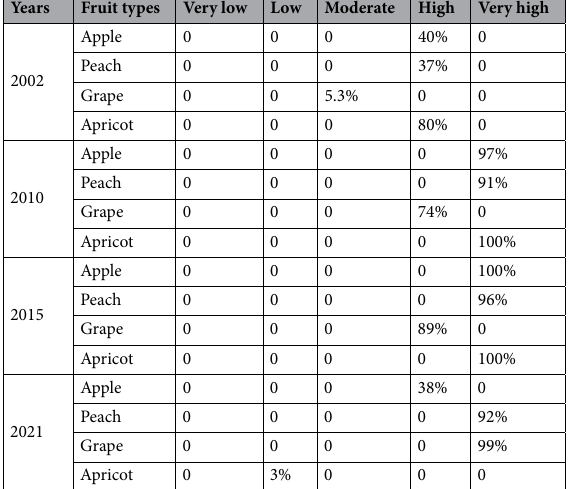
Table 8. Frost-damage assessment for each class in different products.